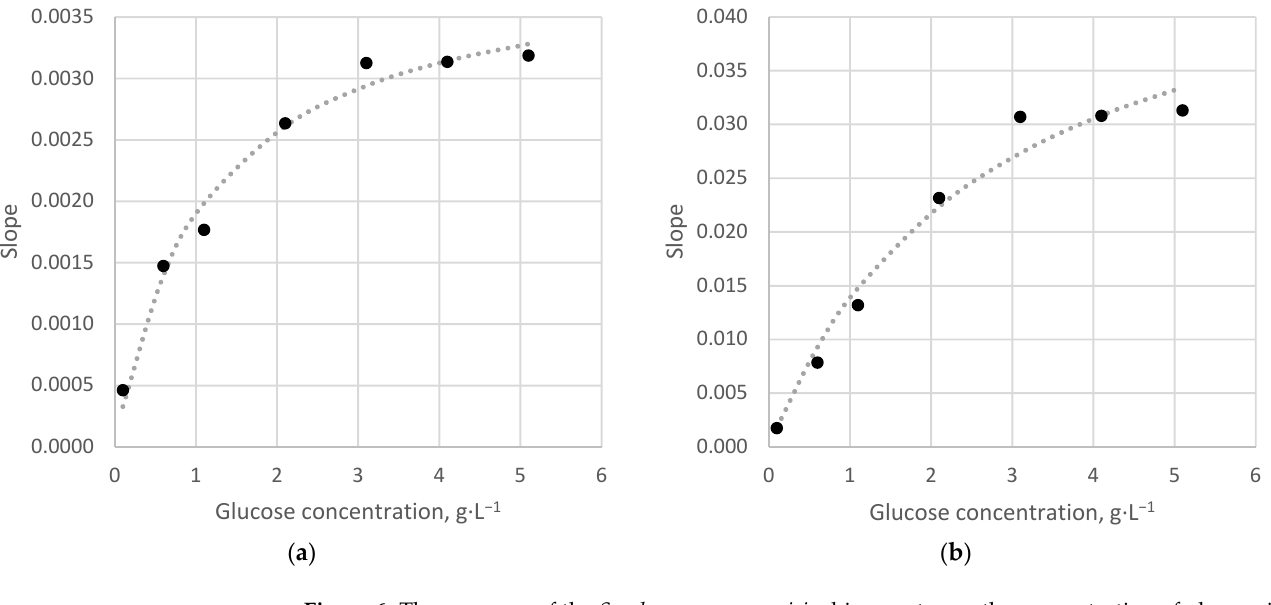
Figure 6. The response of the Saccharomyces cerevisiae bioreceptor on the concentration of glucose in the microfluidic cell: ( a )—Clark electrode; ( b )—optical oxygen sensor. Flow rate 1 mL·min − 1 , loop volume 0.2 mL.